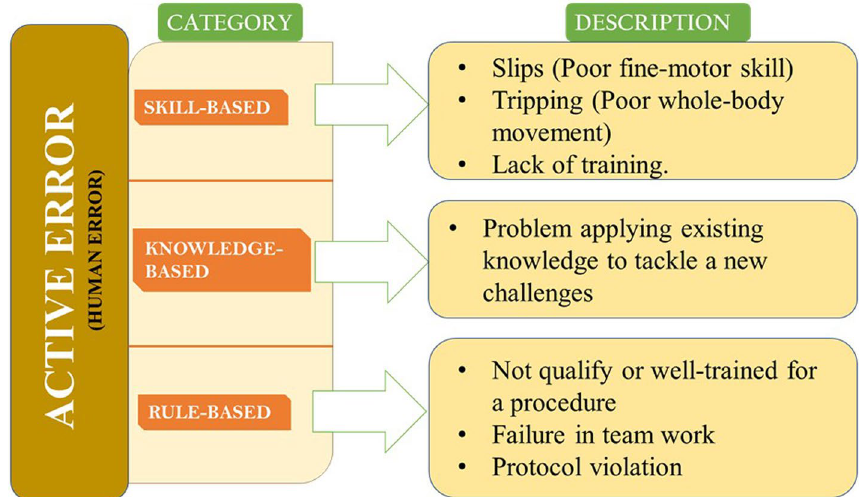
Fig. 1 Categories of human error. Human errors may arise due to poor skills required to execute tasks (skill-based), lack of relevant knowledge required to tackle new challenges (knowledge-based), and non-conformance to rules